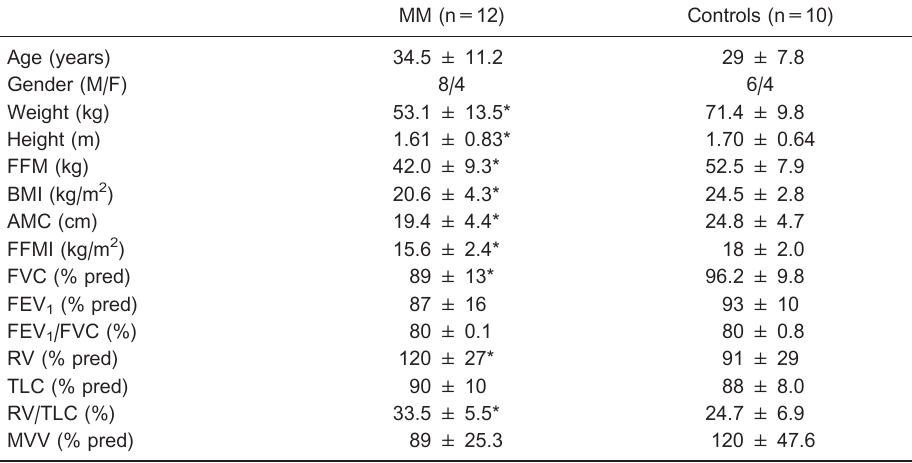
Table 1. Characteristics of patients with mitochondrial myopathy (MM) and healthy